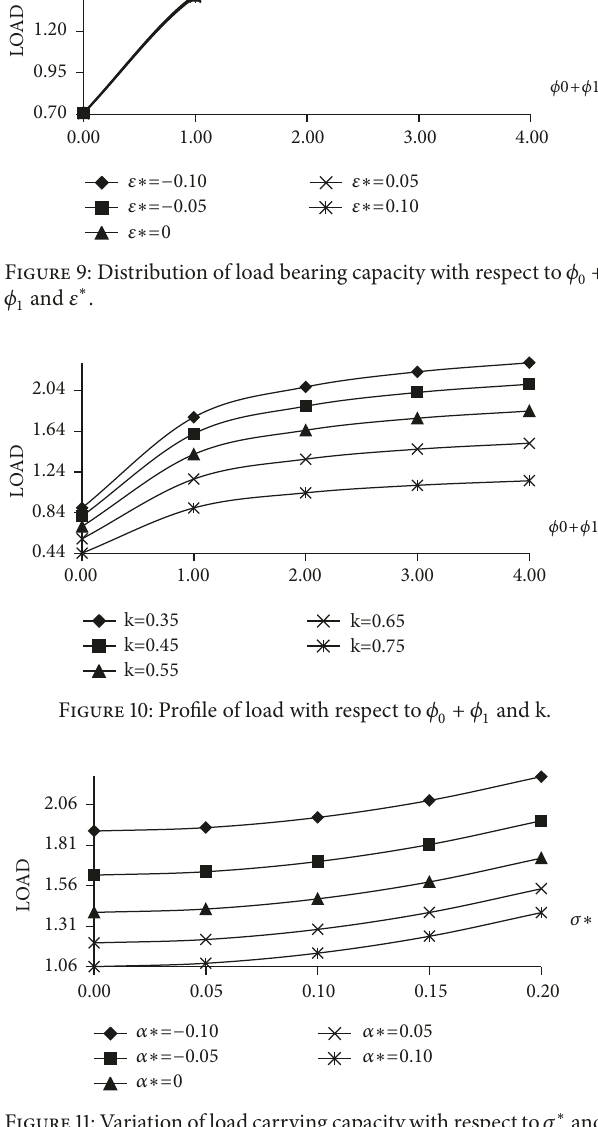
Figure 7: Profile of load with respect to 𝜙 0 + 𝜙 1 and 𝜎 ∗ .